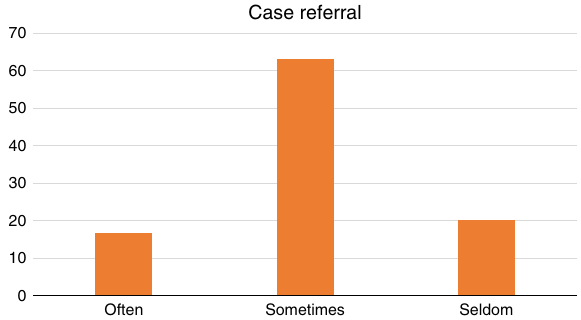
Figure 6. Received referral of potential growth modification cases at ideal